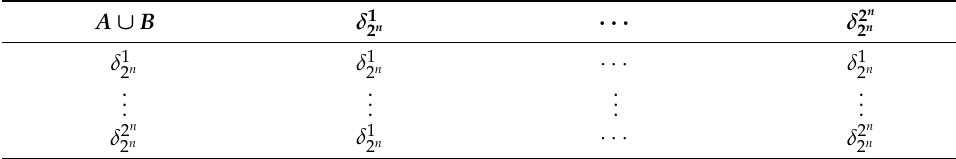
Table 8. Union in vector form.